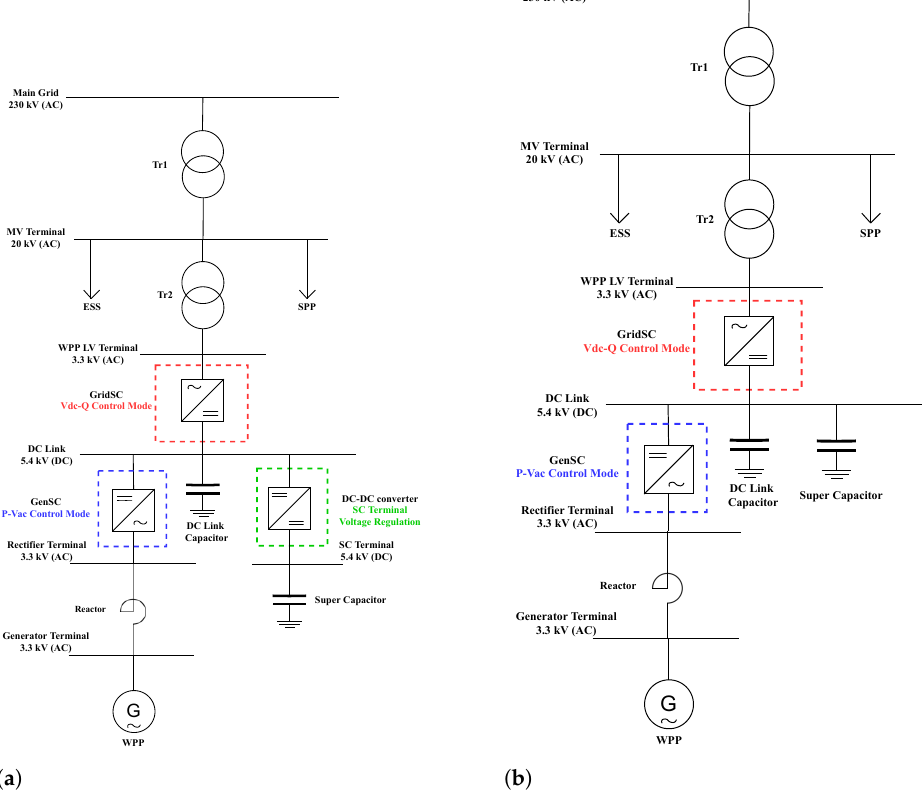
Figure 3. WT model with integration of SC. ( a ) WT model integrating SC via a DC-DC converter. ( b ) WT model directly integrating SC into DC